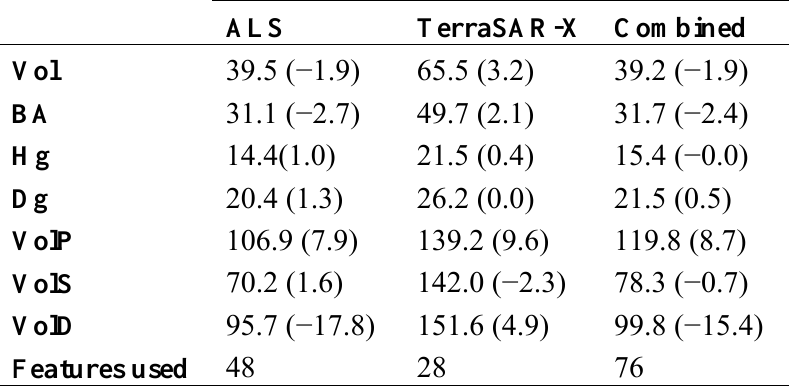
Table 4. Relative RMSEs and relative biases (in parentheses), % of means, of the estimated stand characteristics using the original feature sets.